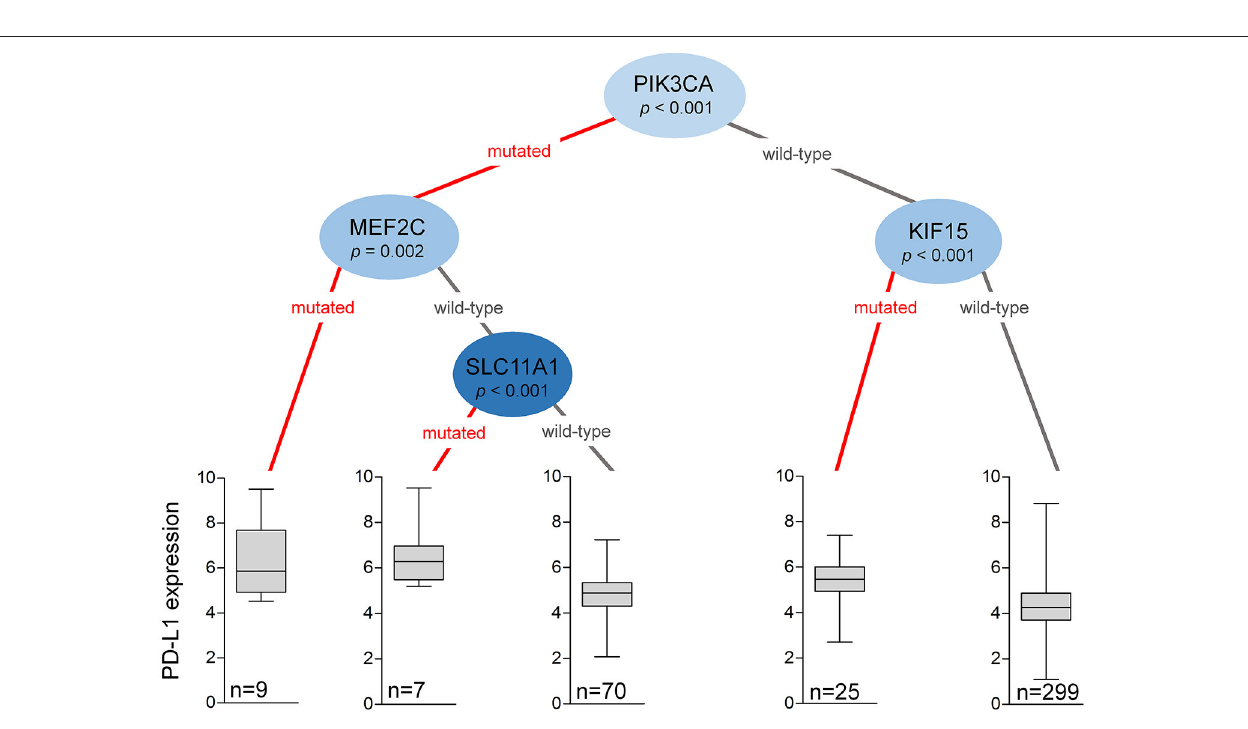
FIGURE 2 | Mutations in the PIK3CA , MEF2C , SLC11A1 , and KIF15 genes help to stratify patients into subcohorts with dissimilar PD-L1 ( CD274 ) expression. The decision tree was generated by analyzing the mutational status of all genes simultaneously with a minimal threshold of having at least 5% of the patients in each node. The plots show Q1/Q2/Q3 within min–max